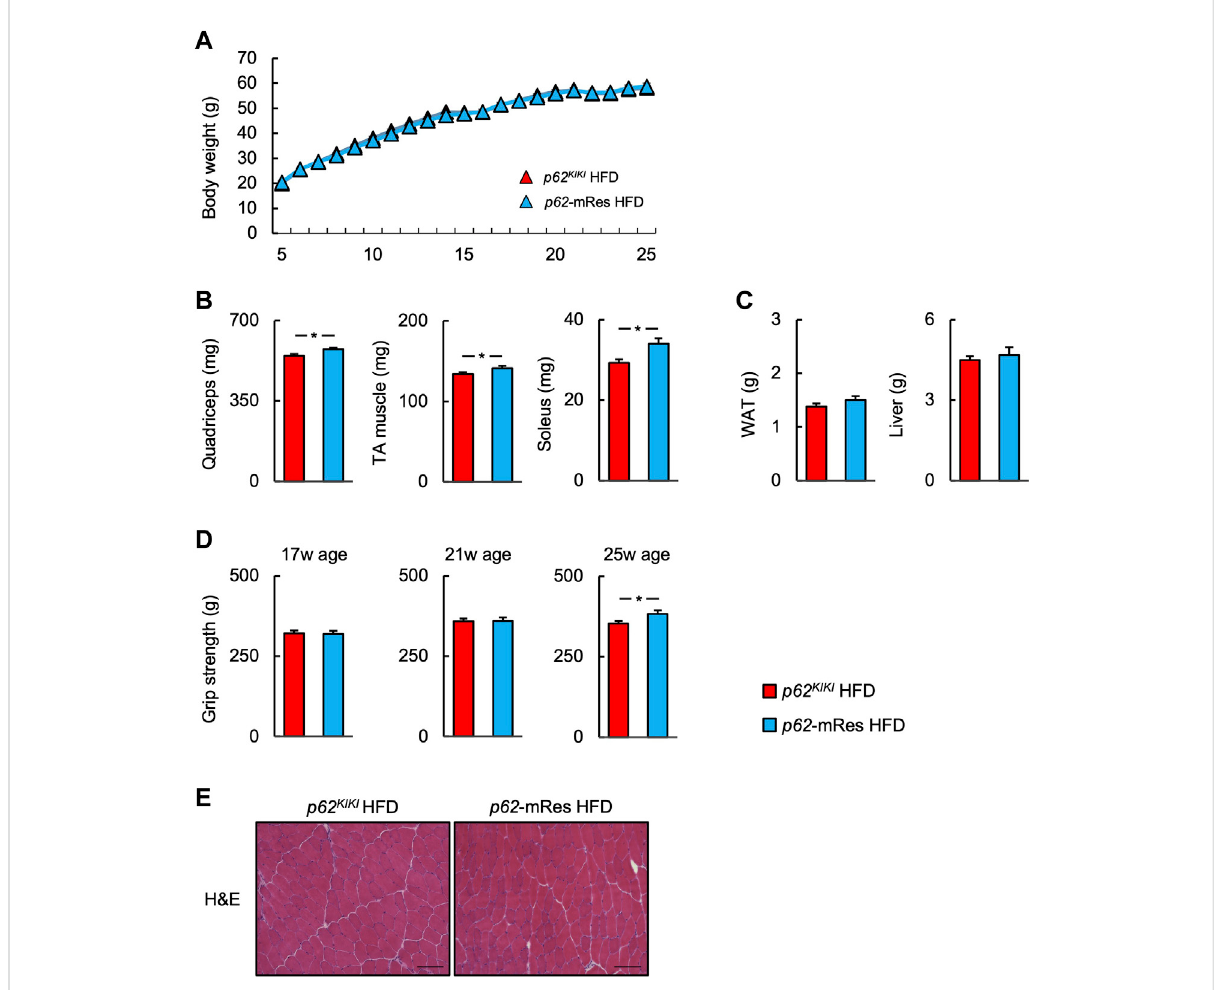
FIGURE 2 p62 gene rescue in muscle does not affect body mass but increases skeletal muscle mass and grip strength. (A) Time course of the changes in body mass in p62 KIKI and p62 -mRes mice fed a high-fat diet (HFD, p62 KIKI ; n = 13, p62 -mRes; n = 14). (B) Masses of the quadriceps , tibialis anterior (TA), and soleus muscles of mice in each group at 25 weeks of age ( n = 13 – 14/group). (C) Masses of the epididymal adipose tissue (WAT) and liver of mice ineachgroup at25 weeks ofage ( n = 13 – 14/group). (D) Gripstrength at17, 21,and 25 weeks ofage ( n = 13 – 14/group). (E) Representative hematoxylin and eosin (H&E)-stained sections of TA muscles from 25-week-old p62 KIKI and p62 -mRes mice fed an HFD. Scale bars represent 100 μ m. Values are mean ± SEM. * p < 0.05 (unpaired t